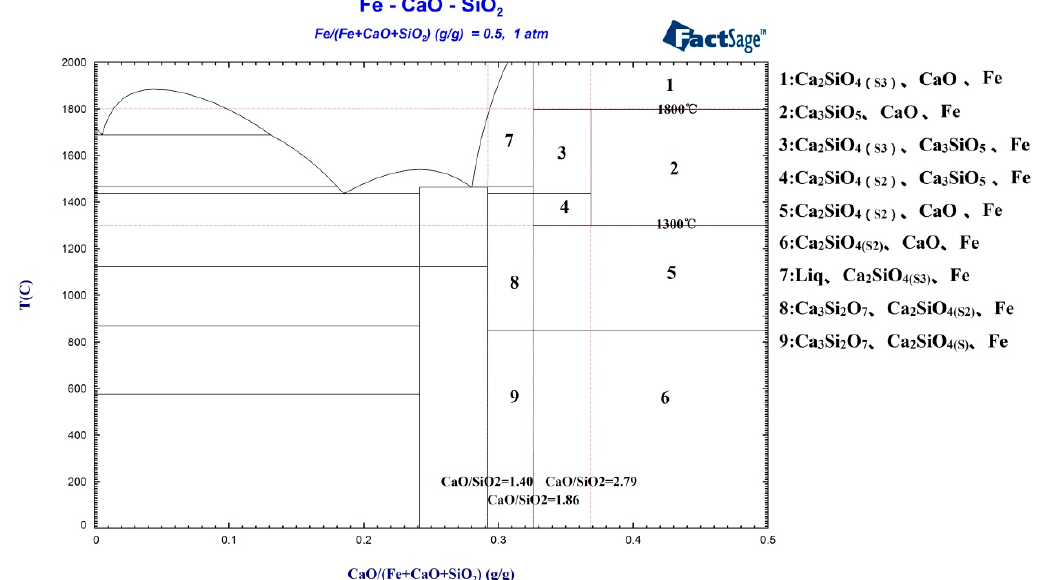
Figure 4. Metals 2020 , 10 , x FOR PEER REVIEW